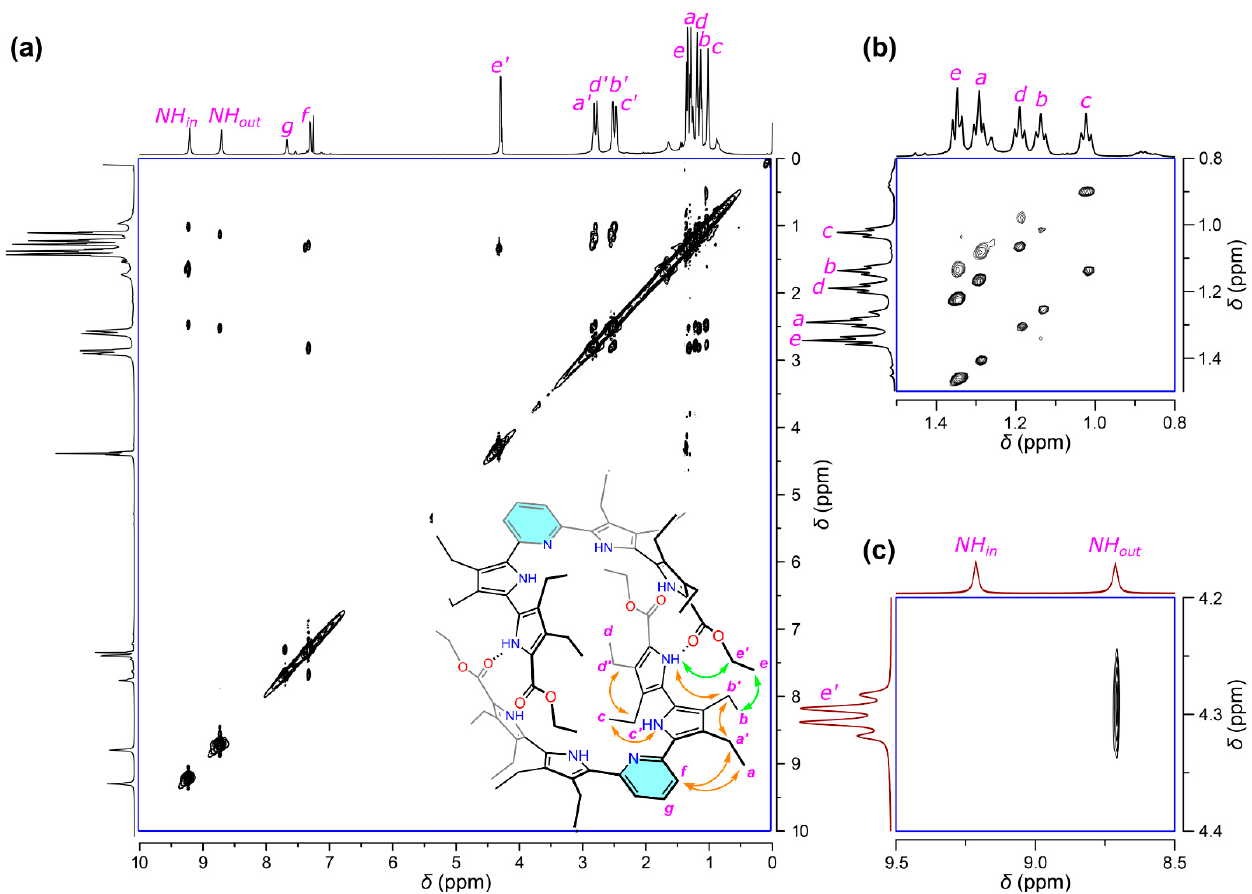
Figure 4. ( a – c ) 1 H– 1 H NOESY spectrum of 10 in CDCl 3 at 298 K. The inset shows the expected dimer structure with the specific interactions.